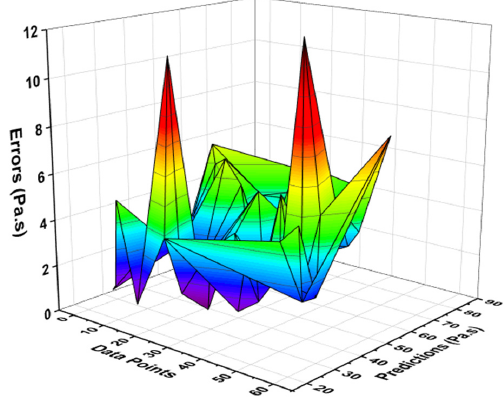
Figure 10. Error distribution of R-F model for plastic viscosity.